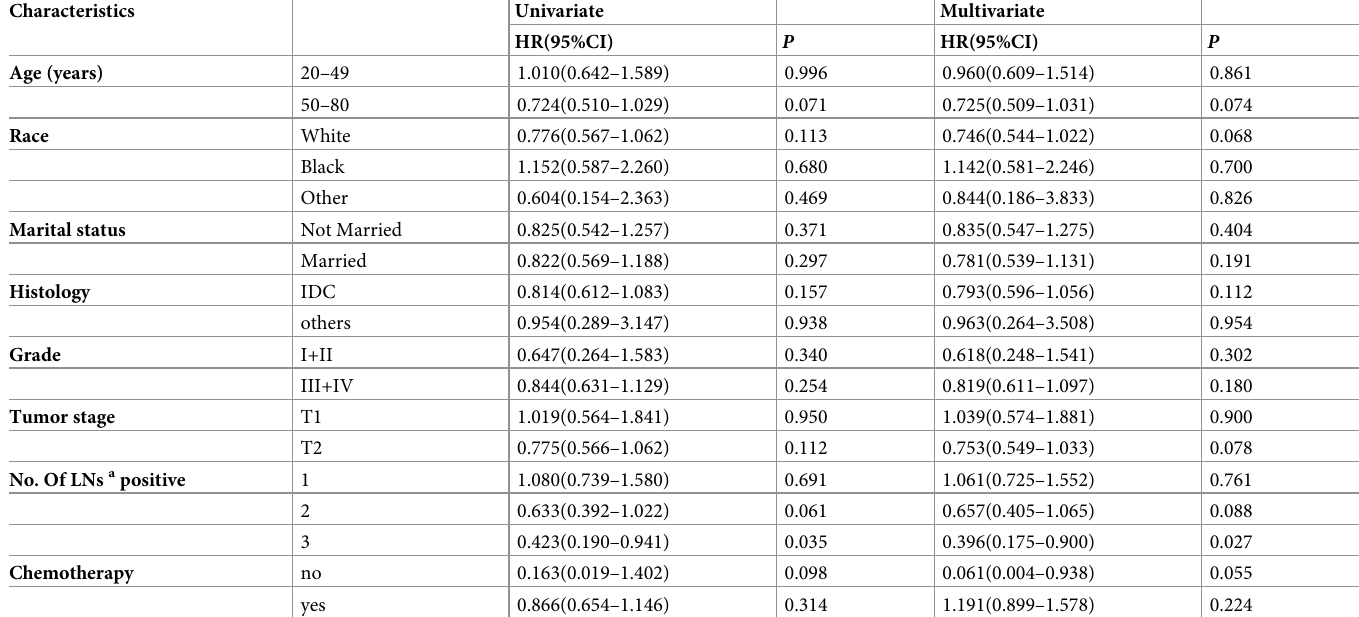
Table 3. Subgroup analysis of BCSS in univariate and multivariate analysis.